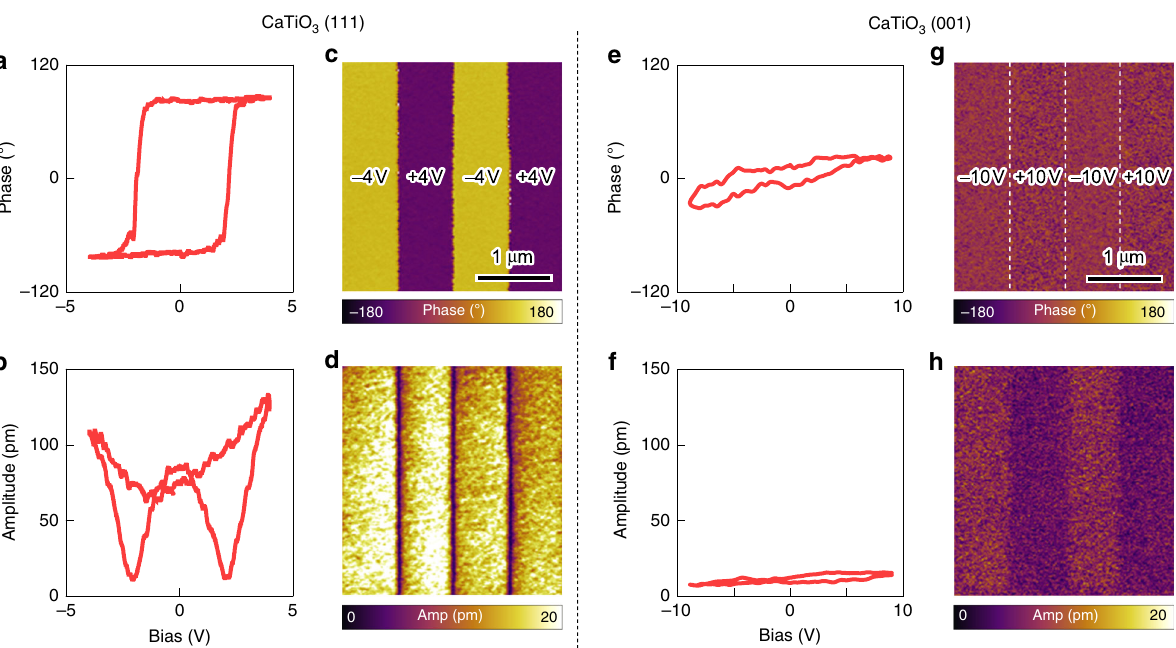
Fig. 4 Switchable and stable polarization in CaTiO 3 (111) fi lms. Switching behavior of the piezoelectric phase ( a ) and amplitude ( b ) in 2.6 nm-thick CaTiO 3 (111) fi lm. Bipolar domain patterns, written on the same CaTiO 3 (111) fi lm. Piezoelectric phase ( c ) and amplitude ( d ) show two stable ferroelectric domains. Nonferroelectric behavior of the piezoelectric phase ( e ) and amplitude ( f ) in 3.8 nm-thick CaTiO 3 (001) fi lm. The absence of domain patterns in the same CaTiO 3 (001) fi lm. Piezoelectric phase ( g ) and amplitude ( h ) show the absence of ferroelectric